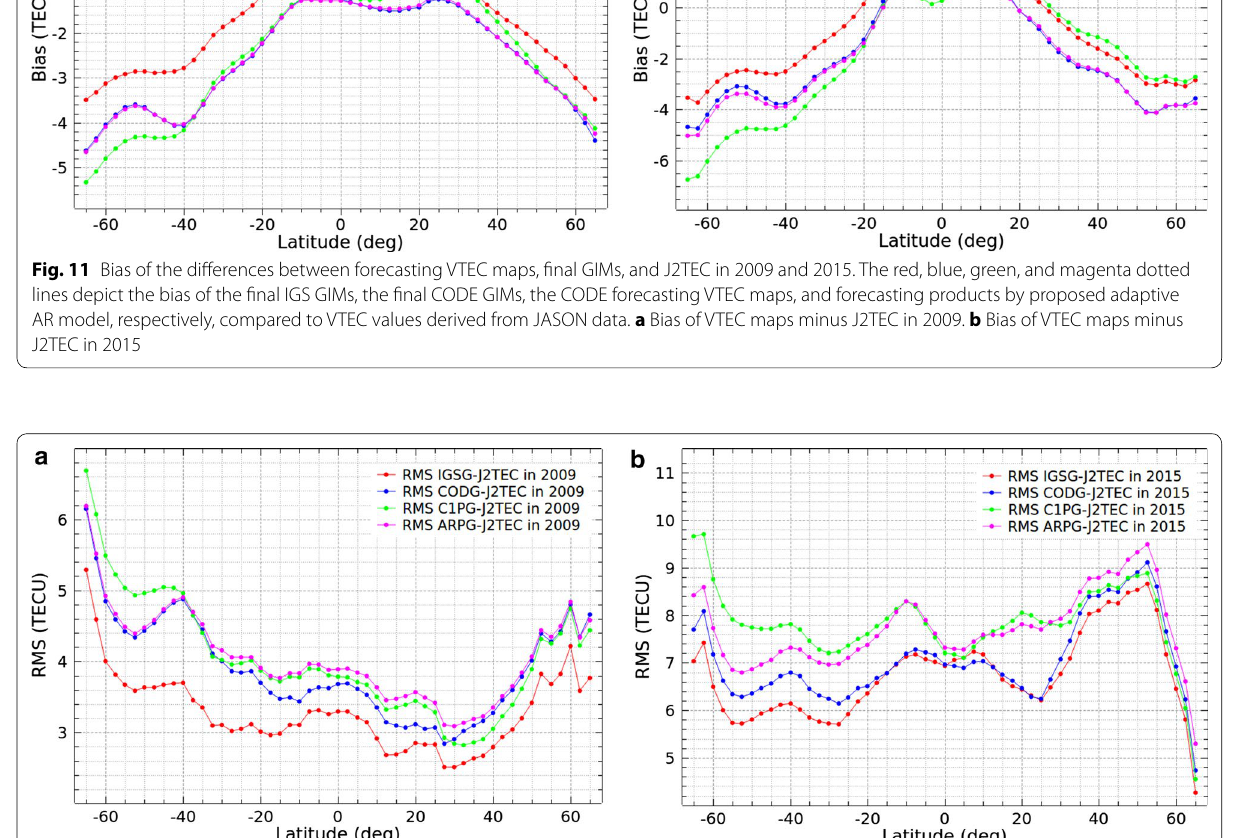
Fig. 12 RMS of the differences between forecasting VTEC maps, final GIMs, and J2TEC in 2009 and 2015. The red, blue, green, and magenta dotted lines depict the RMS of differences between the final IGS GIMs, the final CODE GIMs, the CODE forecasting VTEC maps, and forecasting products by proposed adaptive AR model, respectively, and the VTEC values derived from JASON data. a RMS of VTEC maps minus J2TEC in 2009. b RMS of VTEC maps minus J2TEC in